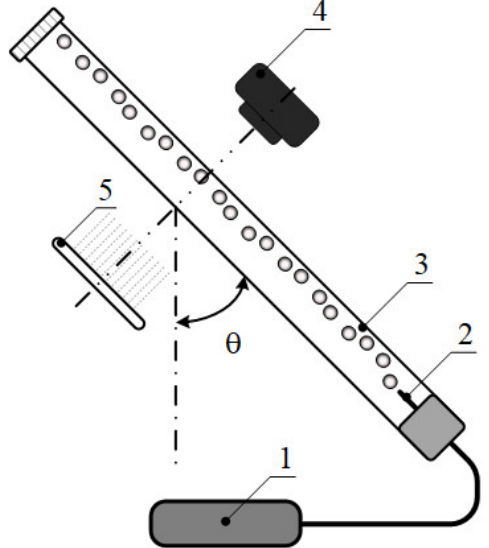
Figure 1. Experimentalsetup.: 1—flowratemeter; 2—capillary; 3—testsection; 4—camera;